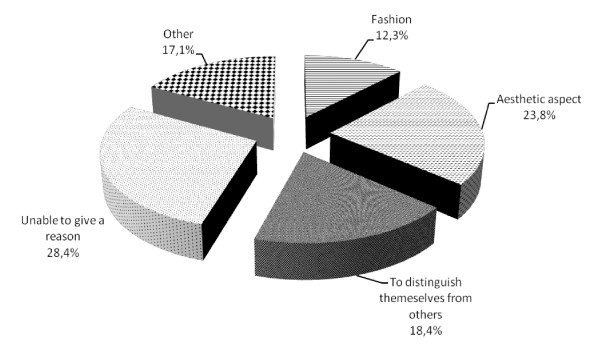
Reasons for making a body art. Others include: to emulate a familiar (3.1%); to better integrate in the society (4.5%); to feel better (6.5%), to better health conditions (0.6%); to follow a very important person (2.4%)